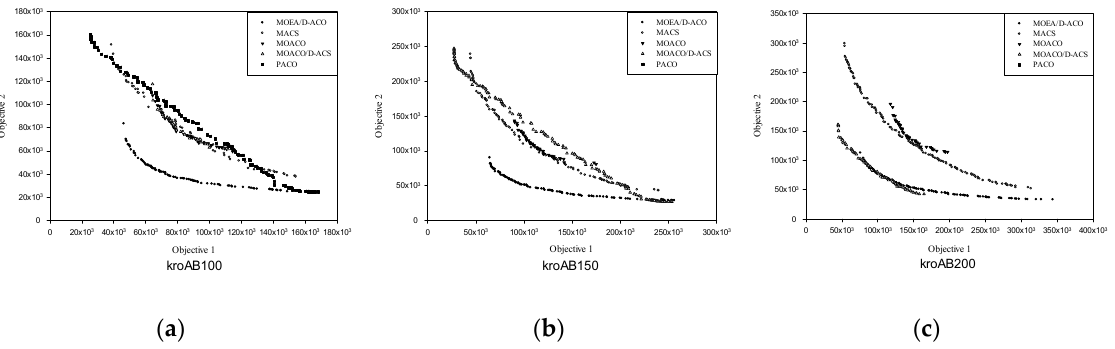
Figure 6. Approximate Pareto Fronts on some instances shown as ( a ) for kroAB100, ( b ) for kroAB150 and ( c ) for kroAB200.